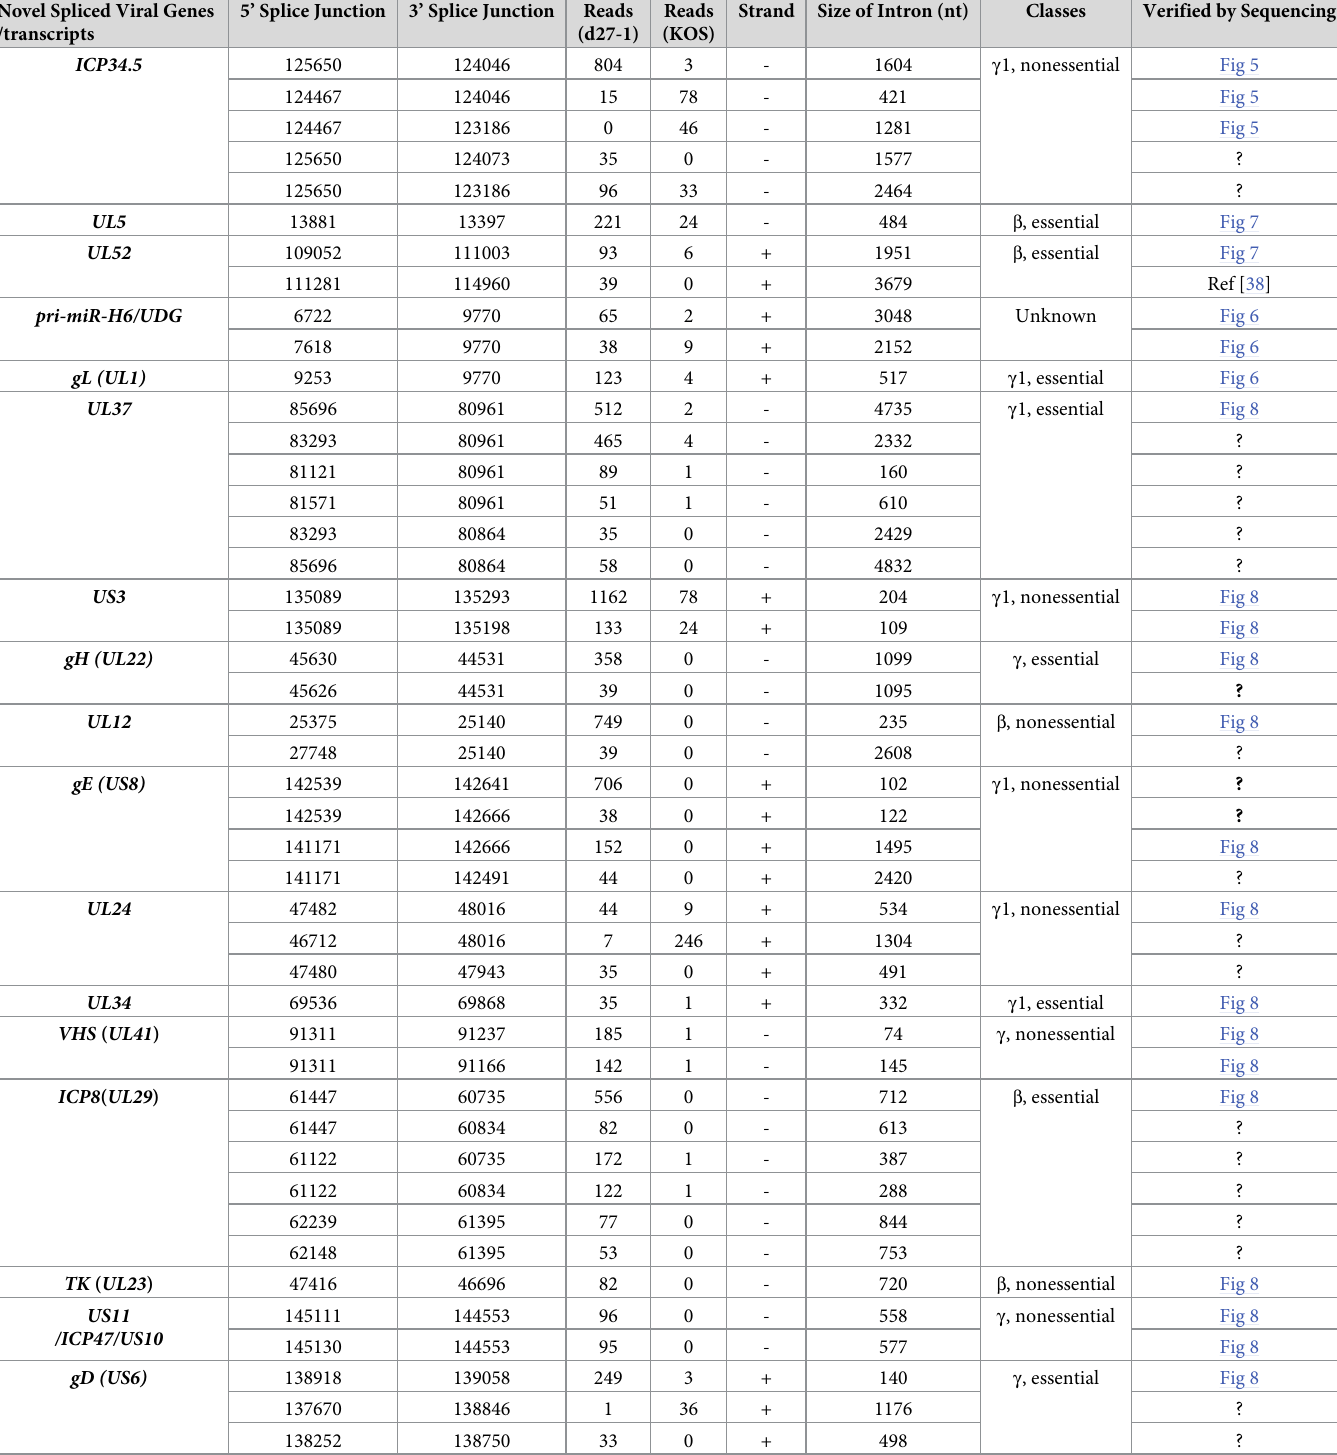
Table 2. List of novel splice sites in previously unknown spliced genes and transcripts identified in the ICP27 mutant virus and wide-type HSV-1 (KOS) infected cells. Novel Spliced Viral Genes